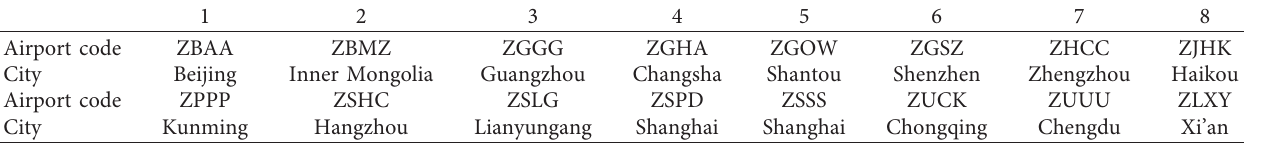
Table 2: A sample of